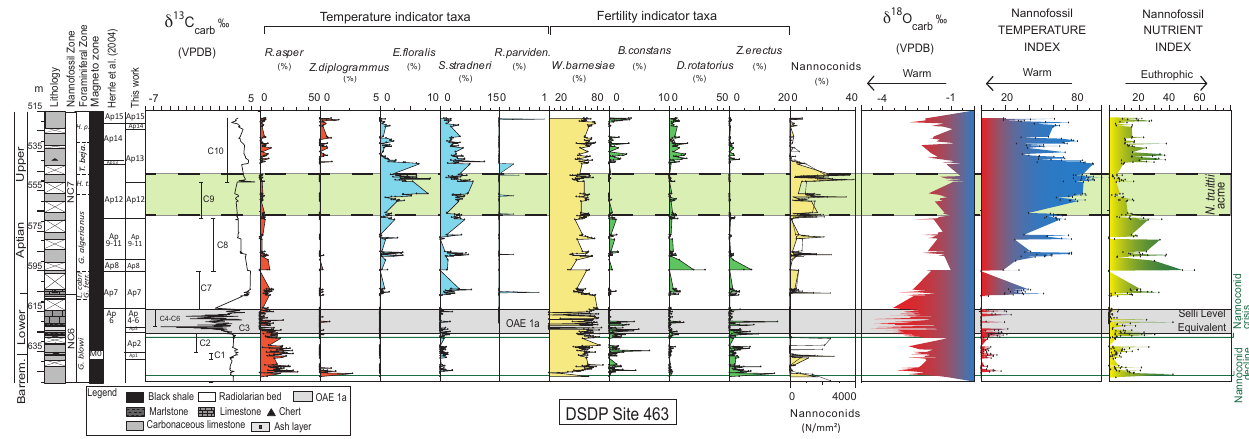
Figure 5. DSDP Site 463 Mid-Pacific Mountains: fluctuations of calcareous nannofossil temperature and fertility indicator taxa. Temperature (TI) and nutrient (NI) indices based on calcareous nannofossils (low values of the TI indicate high temperatures and vice versa; high values of the NI indicate high surface-water productivity and vice versa). δ 13 C is from Price (2003), Ando et al. (2008) and Bottini et al. (2012). Nannofossil and foraminiferal biostratigraphy is from Erba (1994) and Ando et al. (2008). Magnetostratigraphy is from Tarduno et al. (1989). Bulk δ 18 O data are from Price (2003), Ando et al. (2008) and this